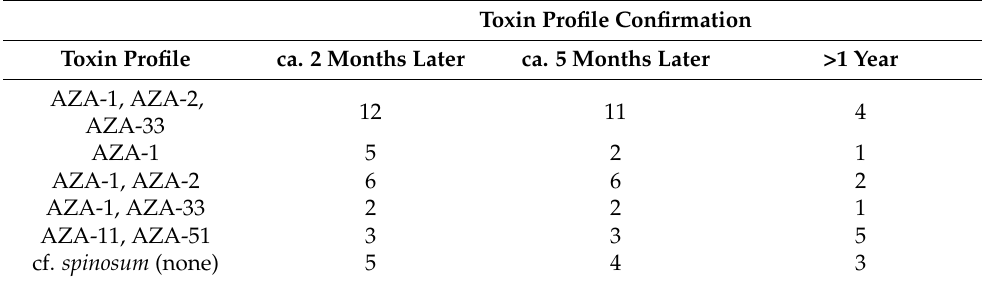
Table 4. Az. spinosum strains, stability of toxin profile. Data display the number of strains tested for toxin profile confirmation at different time points after isolation. AZA =